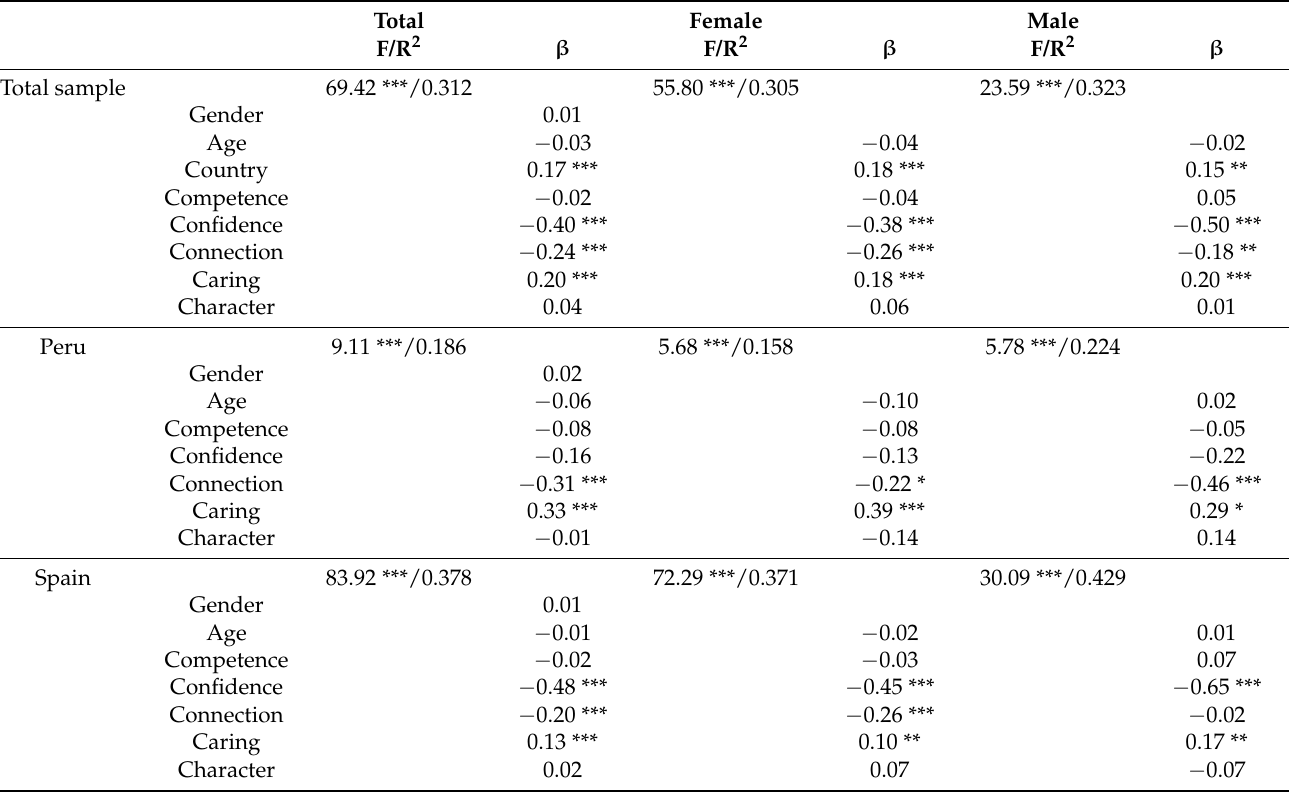
Table 5. Linear regression analyses to explain depressive symptoms based on the 5Cs of PYD